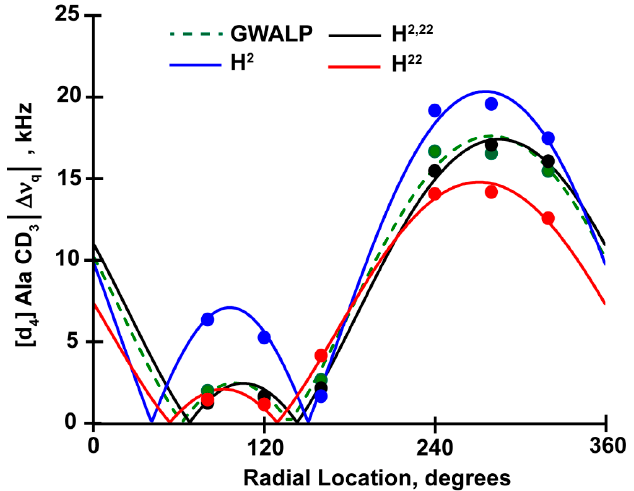
Figure 3. Quadrupolar wave plot for oriented GWALP23 family peptides with histidine residues H2 and/or H22 in DOPC lipid bilayers.